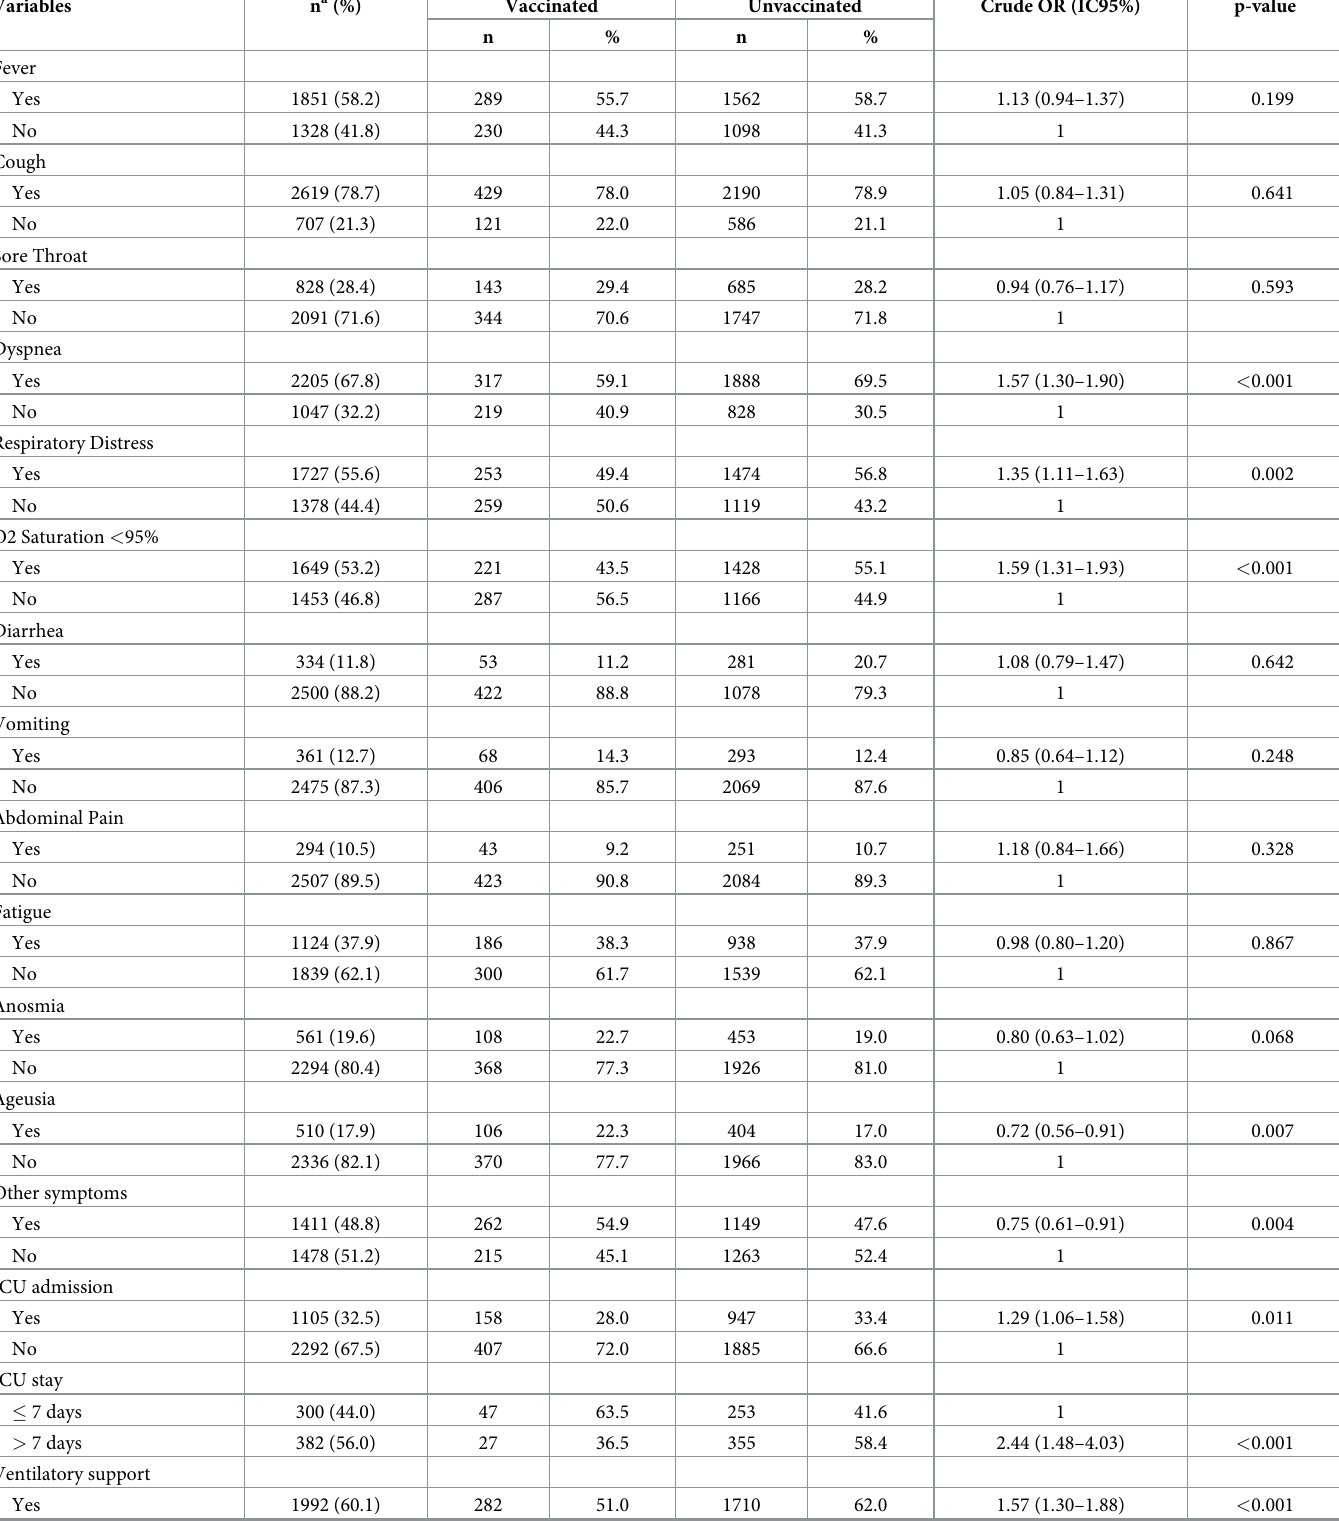
Table 2. Univariate analysis of clinical characteristics and evolution of pregnant and postpartum women with SARS according to the vaccination status against Covid-19. Brazil, 2021. Variables n a (%) Vaccinated Unvaccinated Crude OR (IC95%) p-value n % n